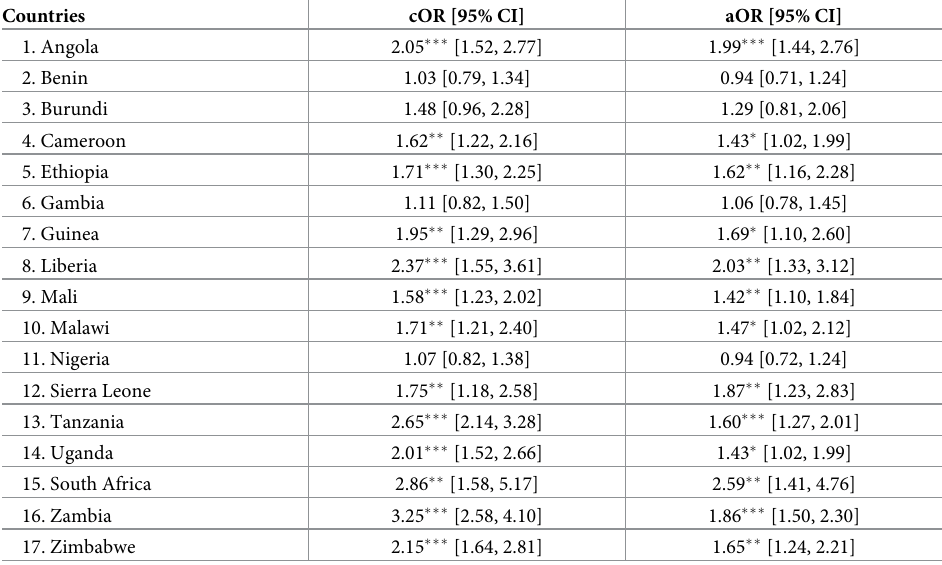
Table 4. Association between mother and newborn skin to skin contact and timely initiation of breastfeeding seg- regated by country.